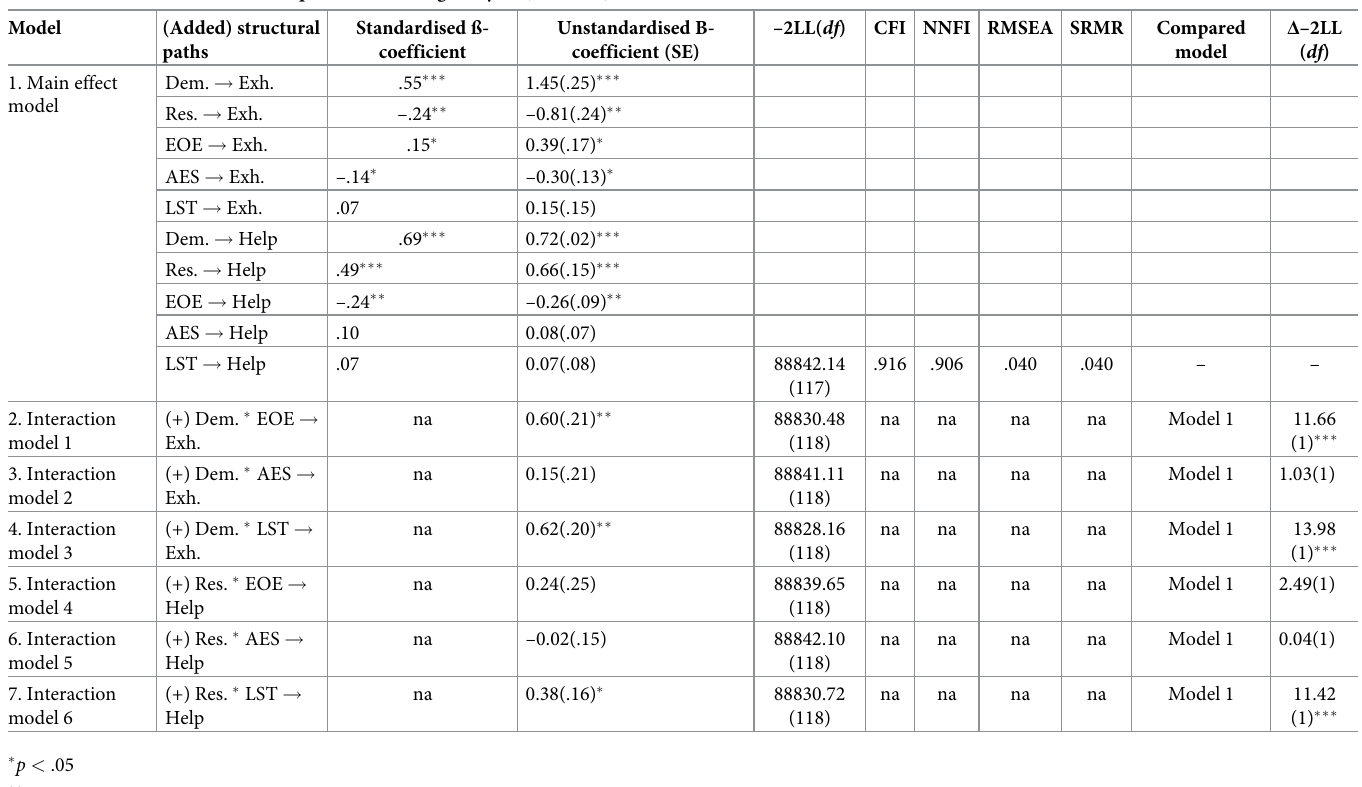
Table 4. Results of the structural equation modelling analyses ( N = 1019).